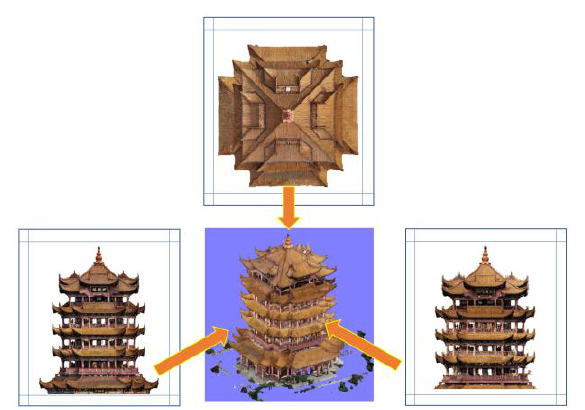
Figure 9 . Facade images of the Yellow Crane